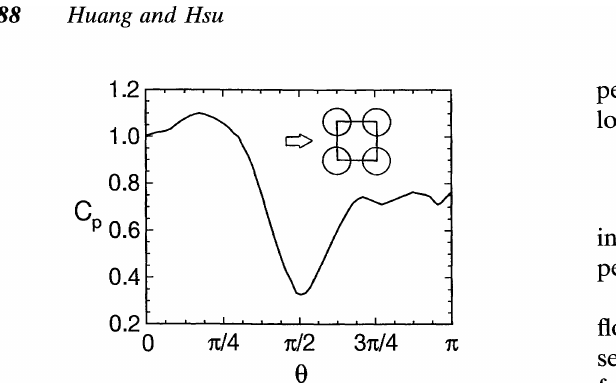
FIGURE 7 Distribution of pressure coefficient with tube angles for an in-line tube bundle.